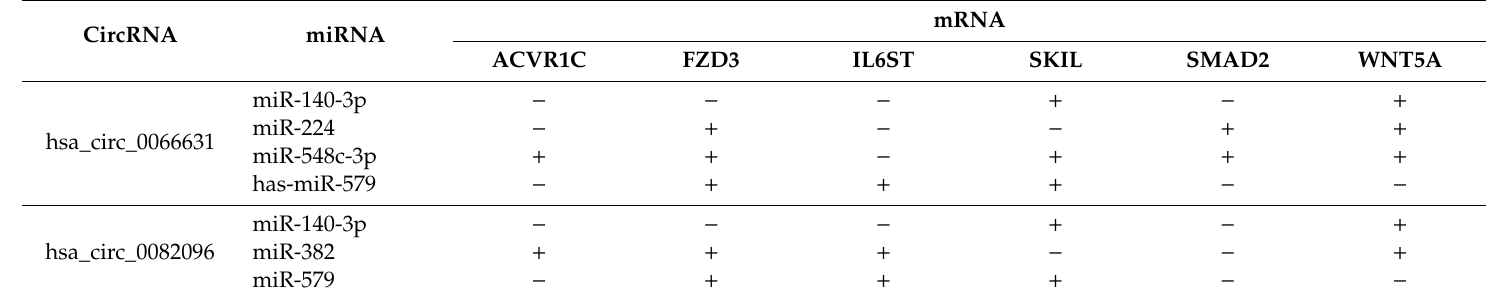
Table 2. CircRNA–miRNA–mRNA regulatory axis